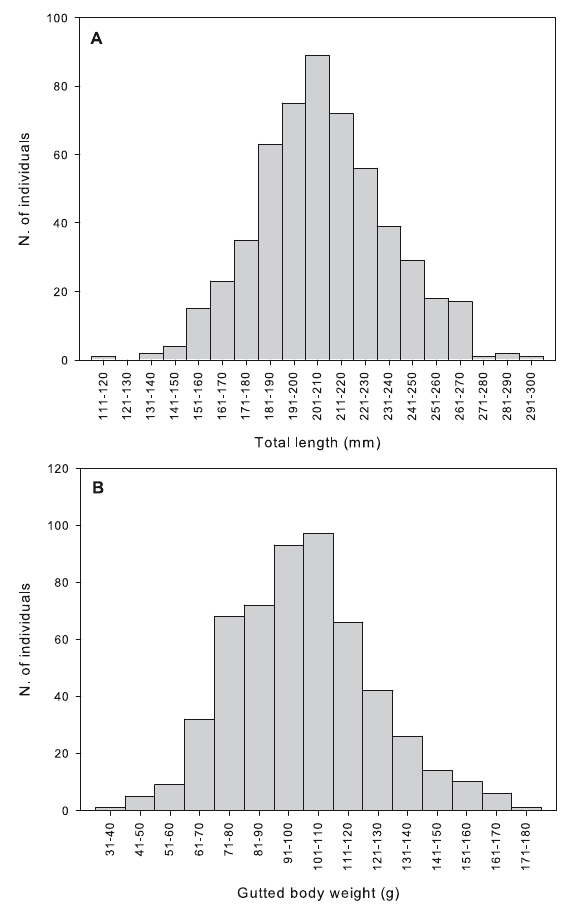
Fig . 2. – Size (A) and gutted body weight (B) distribution of H. sanctori at Gran Canaria island,